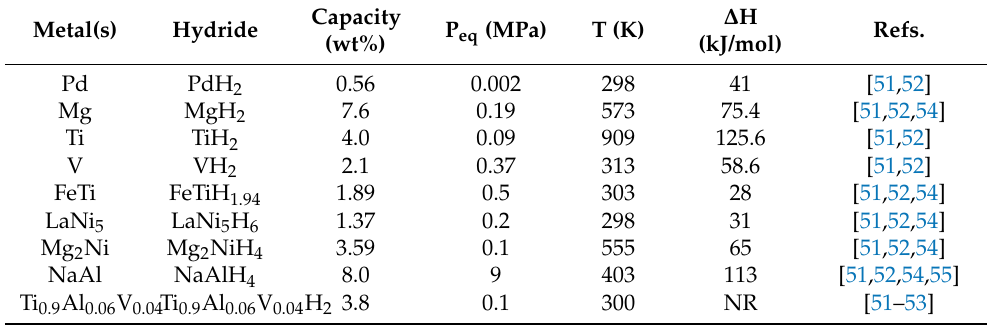
Table 1. Storage capacity [51–53] and ∆ H values [52,54,55] of several intermetallic compounds.